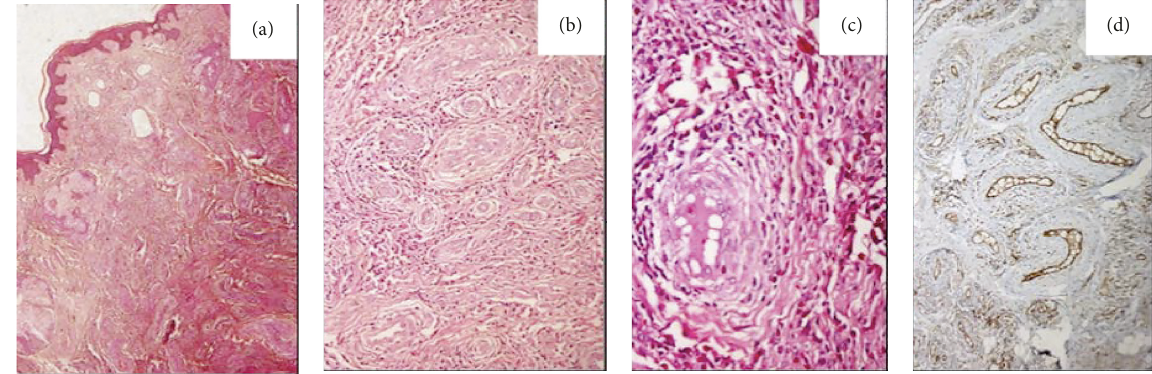
Figure 2: Photomicrograph showing a circumscribed lesion located in the dermis, composed of variably sized vascular spaces with cellular infiltrate (a) (H&E stain, 4x). The lesion is showing vascular spaces with plump endothelial cells and interstitial increase in eosinophil, lymphocyte, and plasma cells (b) (H&E stain 10x) and (c) (H&E stain, 20x). Immunohistochemistry showing endothelial cells positive for CD31